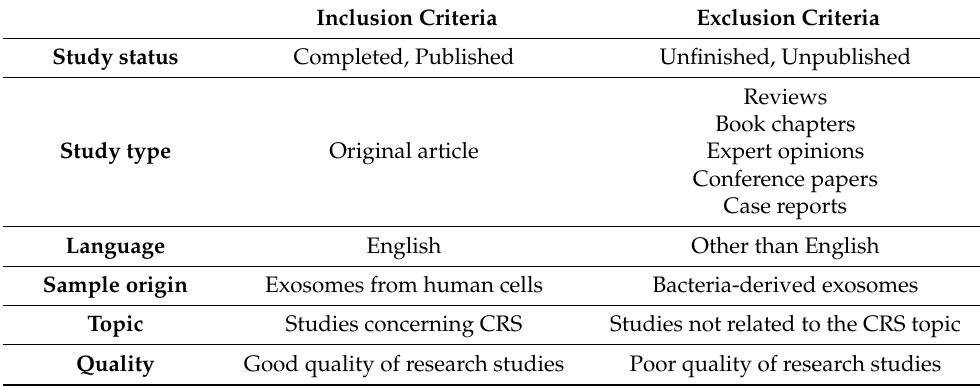
Table 1. The inclusion and exclusion